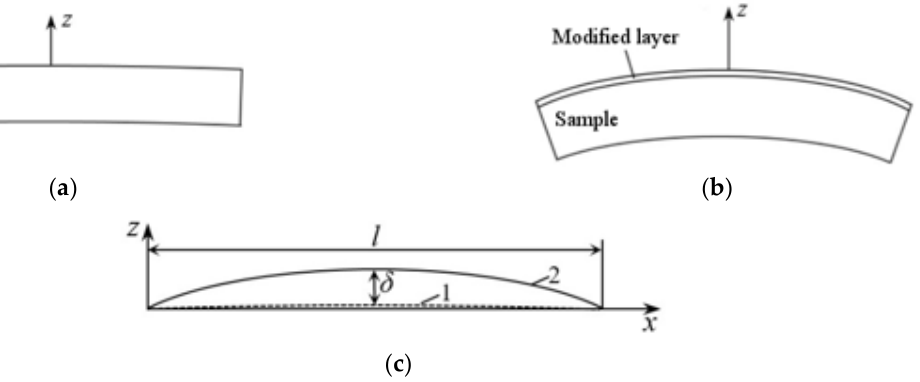
Figure 1. Diagram for determining the normal curvature: ( a ) original sample (with curvature before modification/coating); ( b ) sample with curvature after modification/coating; ( c ) determination of the normal curvature value of the sample due to modification/coating (1 — smoothed profile of the original surface; 2 — smoothed surface profile after droplet impact or modification/coating and droplet impact).